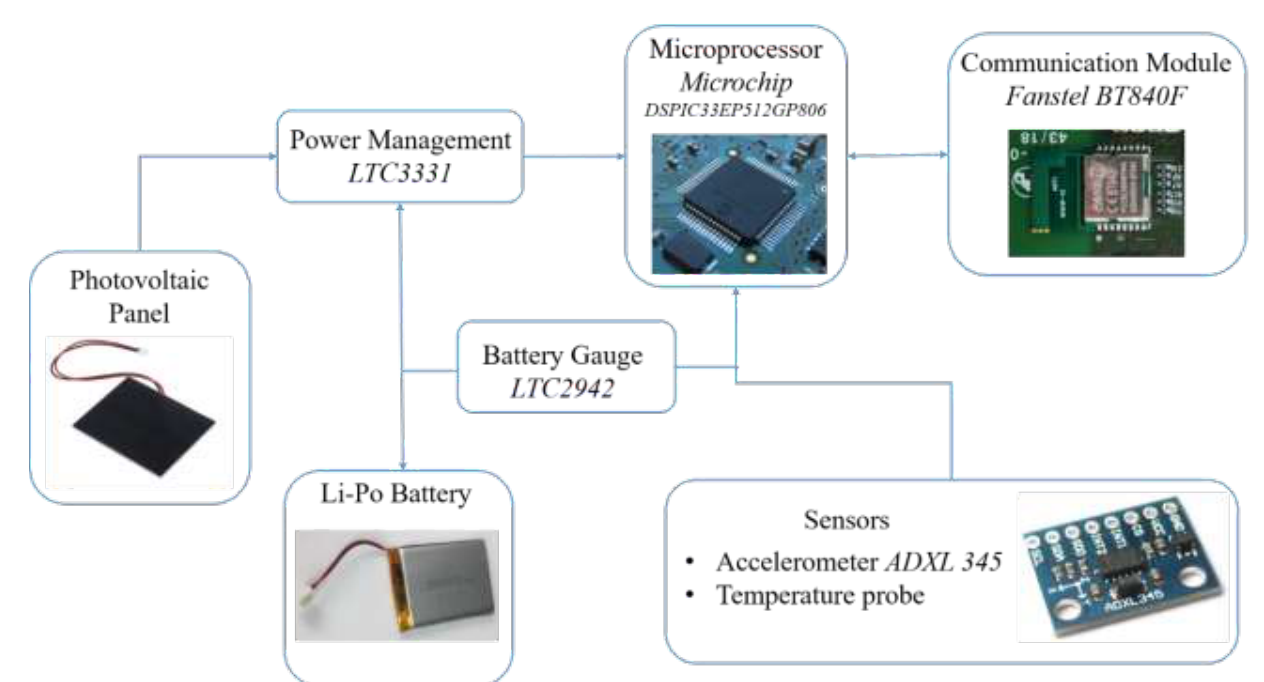
Figure 2. Functional scheme representing the main components present on the board.